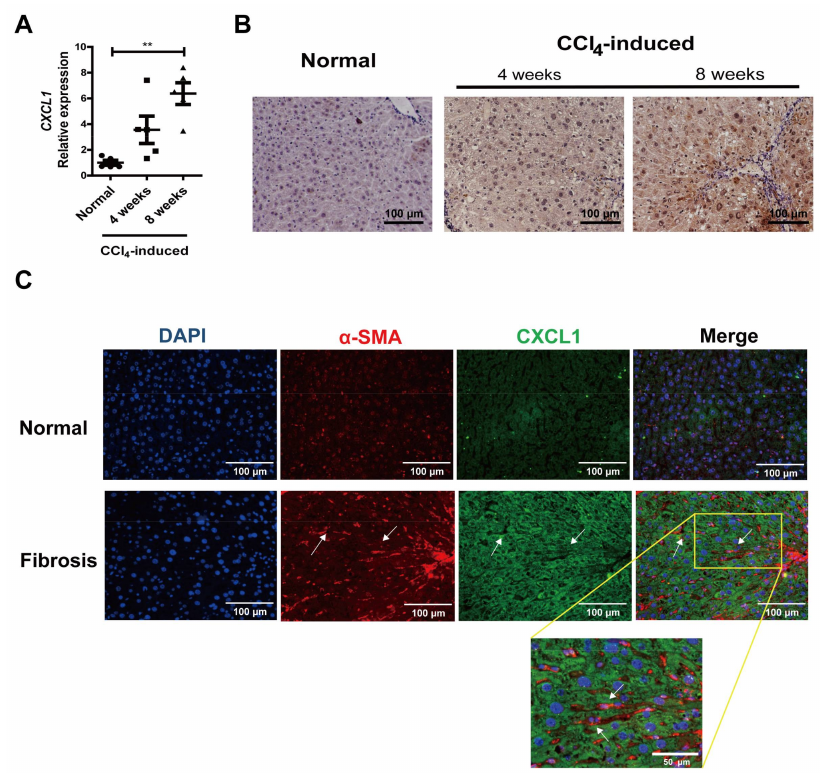
Figure 1. CXCL1 expression increased in liver fibrosis. ( A ) Real-time RT-PCR detection of hepatic gene expression of CXCL1 in normal control and carbon tetrachloride (CCl 4 )-treated mice ( n = 5). Glyceraldehyde-3-phosphate dehydrogenase (GAPDH) was used as the normalization control, ** p < 0.01; ( B ) Immunohistochemistry analysis of CXCL1 in liver tissues from CCl 4 -induced mice; ( C ) Immunofluorescence detection of CXCL1 and α -SMA in liver tissues from normal control and CCl 4 -induced mice (eight weeks). Arrows indicate CXCL1 (green) expression in the activated hepatic stellate cells (HSCs), which are positive for α -SMA